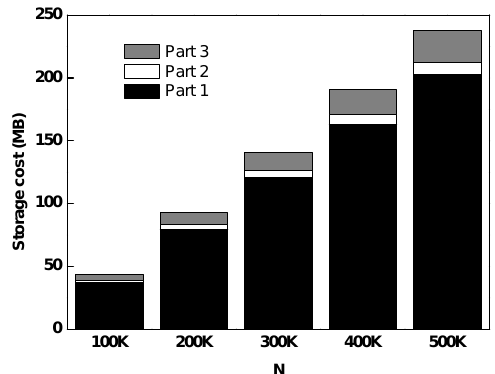
Figure 13. Evaluating the space cost of G-AP-tree + .